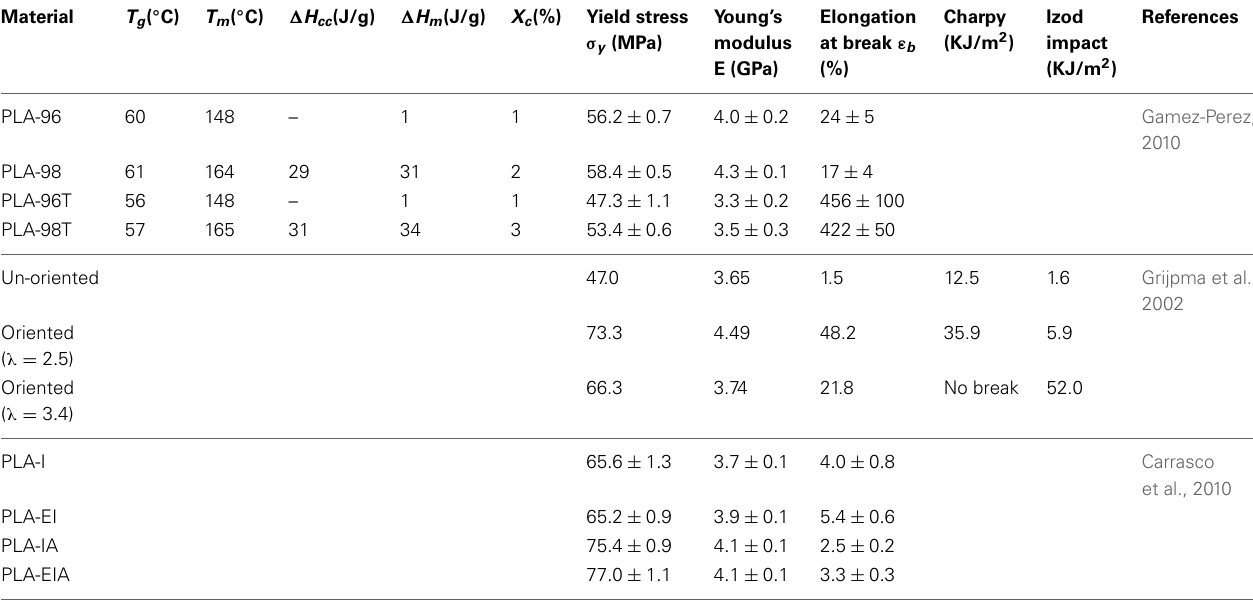
Table 2 | Effect of some (thermo)mechanical treatments and processing on the thermal and mechanical properties of PLA.